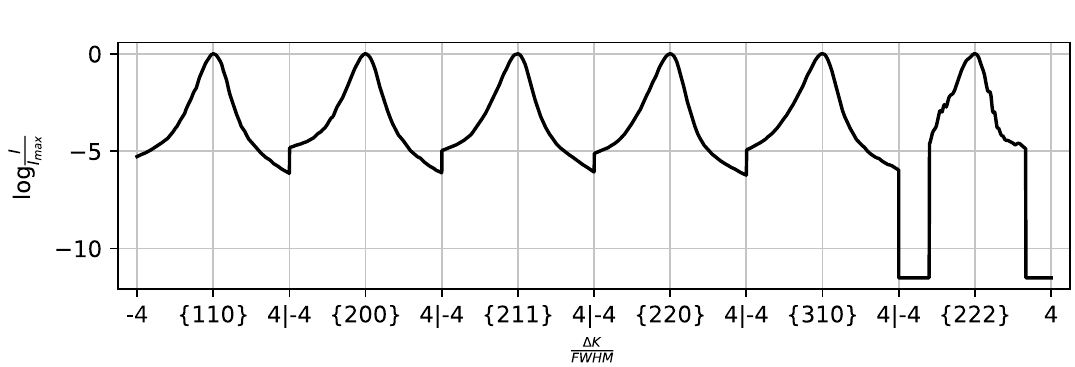
Figure 13. A processed profile taken from the set of experimentally obtained neutron diffraction profiles, here shown on a log scale. The peaks shown were processed to remove background intensity, then normalized with respect to maximum intensity and FWHM